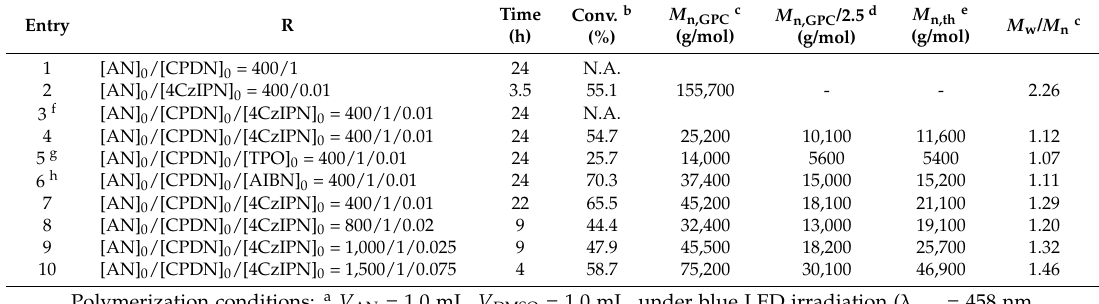
Table 1. Results of photoinduced RAFT polymerization of AN under blue LED irradiation a . Entry